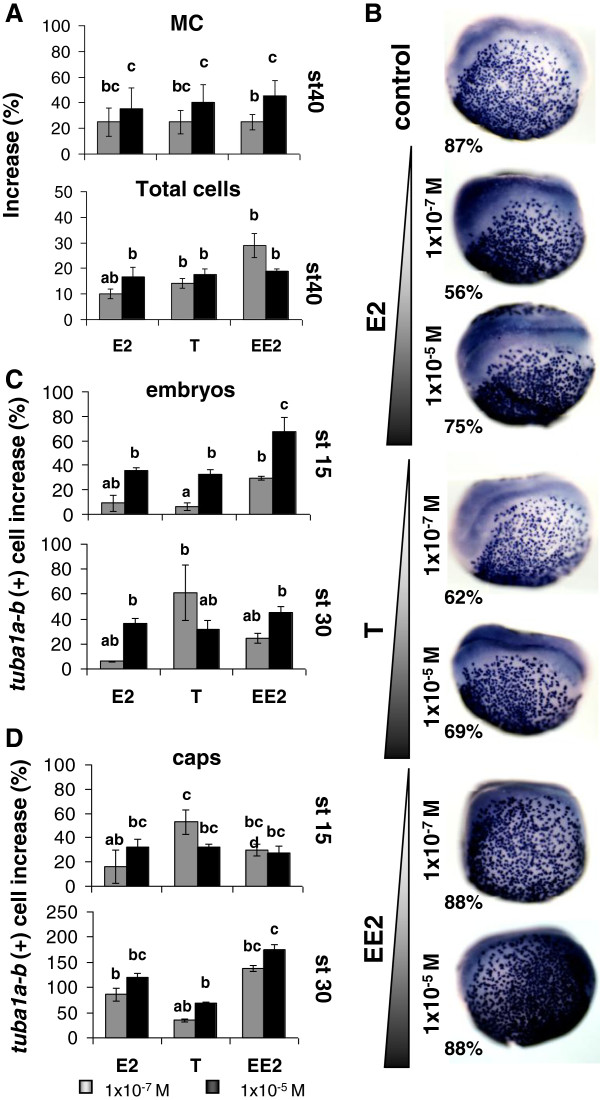
Effect of sex steroids on the abundance of MC cells in Xenopus mucociliary epithelium. A) Increase of MC and total cells by E2, T and EE2 in the skin outer layer of whole embryos st 40, SEM analysis, d.f. = 14. B) E2, T and EE2 increased the apparent density of MC progenitors prior to MCE differentiation (st 15), as revealed by tuba1a-b(+) chromogenic ISH. Images are representative of 24 embryos/condition. C-D) Increase of MC cells by E2, T and EE2 in whole embryos skin and ectodermal explants (caps), as measured by tuba1a-b (+) ISH staining of MC cells prior (st 15) and after (st 30) MCE differentiation, d.f. = 21. A,C,D) Mean ± SD, “a” = control group; statistical significance is represented in a letter code: a indicates no difference with control, all other letters indicate significant difference with the control, shared letters indicate no significant differences between the corresponding data sets. One-way ANOVA, Tukey comparison test, p < 0.05.